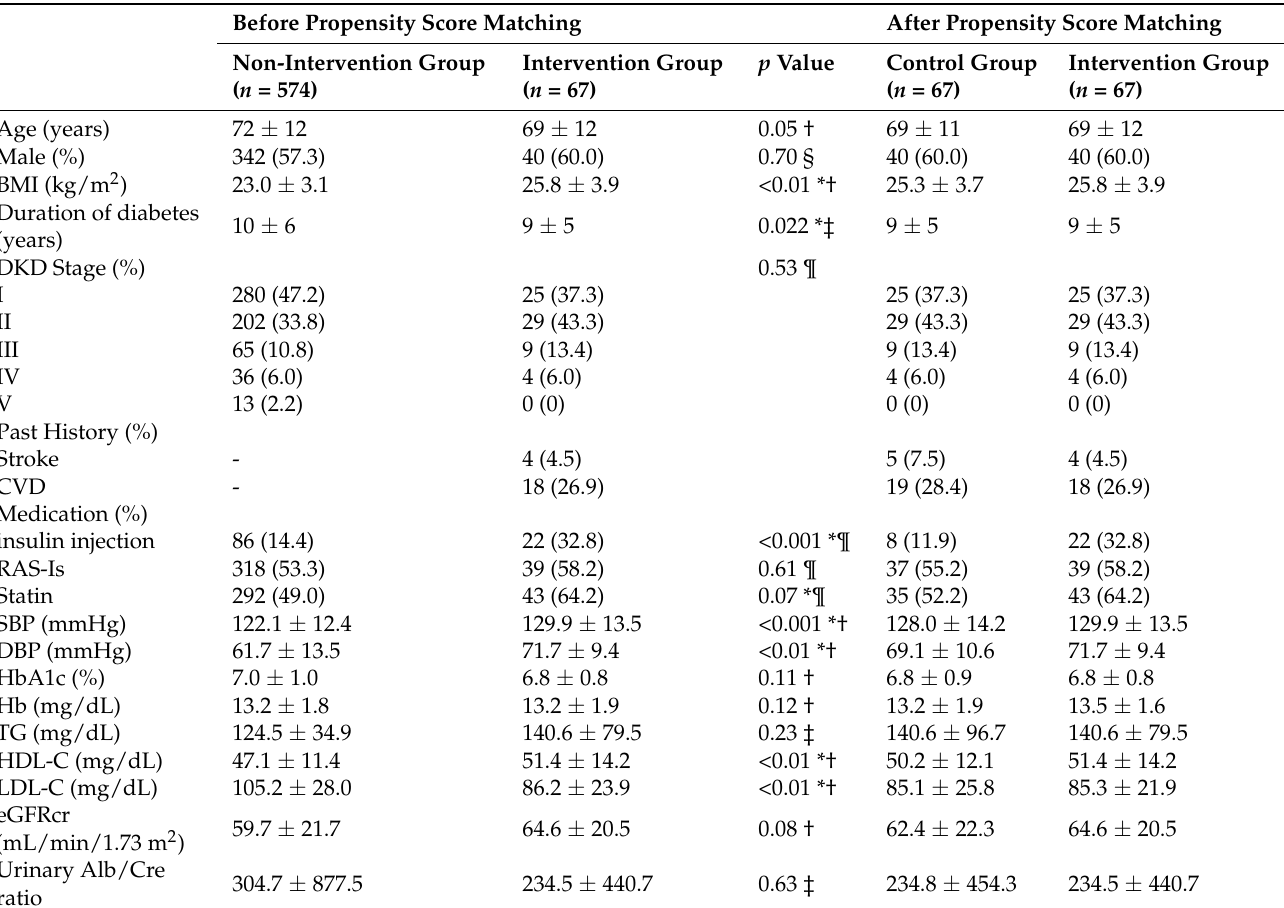
Table 1. Baseline characteristics of participants and non-participants in the intervention before and after propensity score